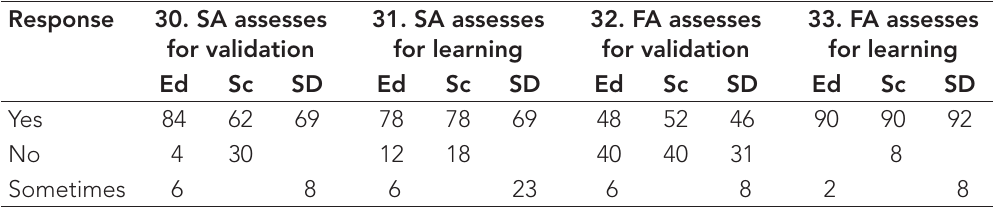
Table 12: Summative and formative assessment assess for validation (grading) or for learning Response